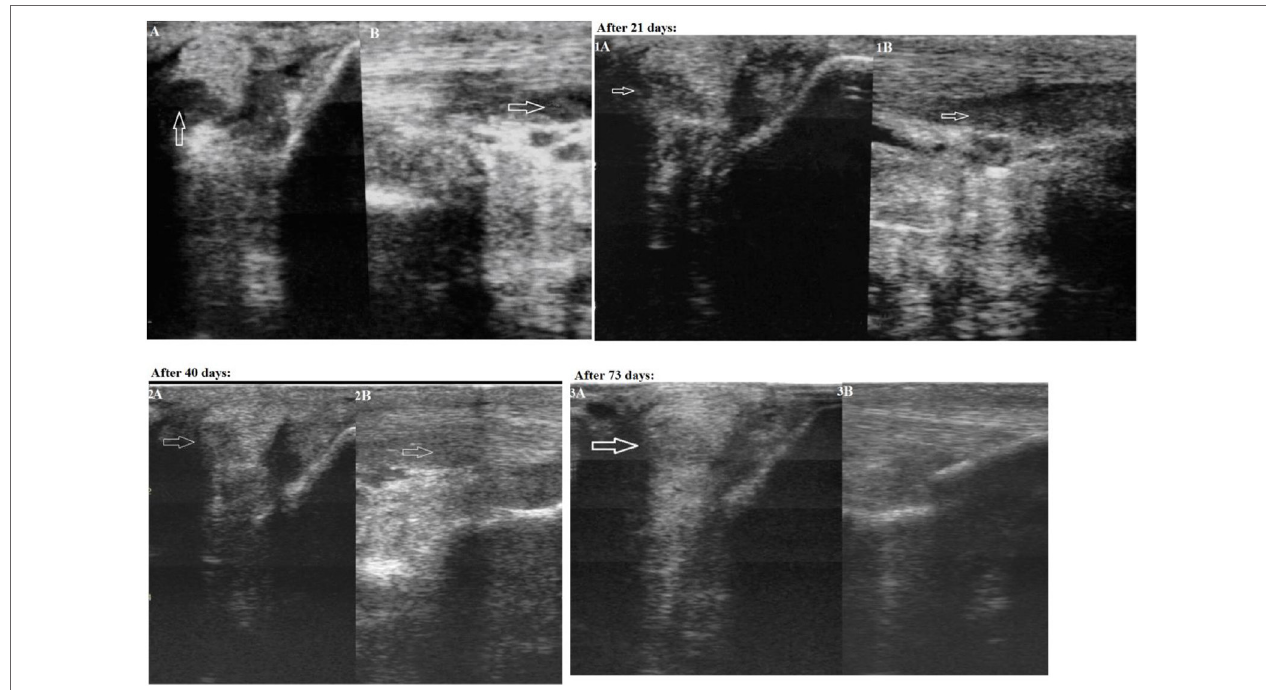
FIGURe 1 | First case—transverse (Panel A) and longitudinal (Panel B) projections of the lateral crus of the suspensory ligament in zone 3C on an ultrasound image (an arrow indicates the anechoic and hypoechoic zone of the injury). Panels 1A and 1B: on Day 21 after the plasmid DNA (pDNA) was administered. Panels 2A and 2B: on Day 40 after the pDNA was administered. Panels 3A and 3B: on Day 73 after the pDNA